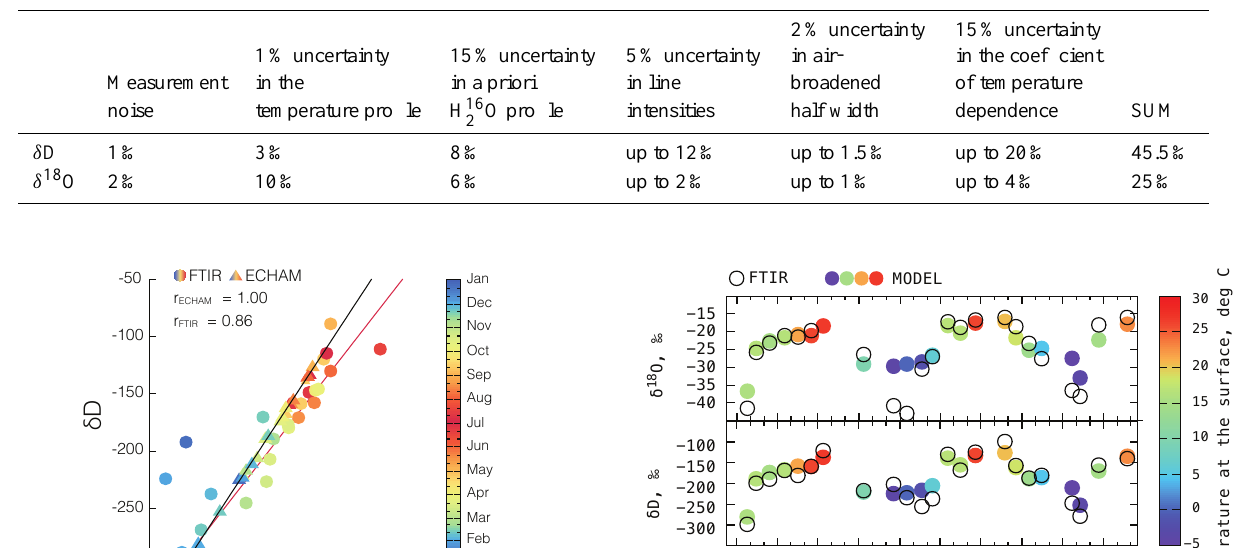
Table 2. Summarized information from the different uncertainty sources